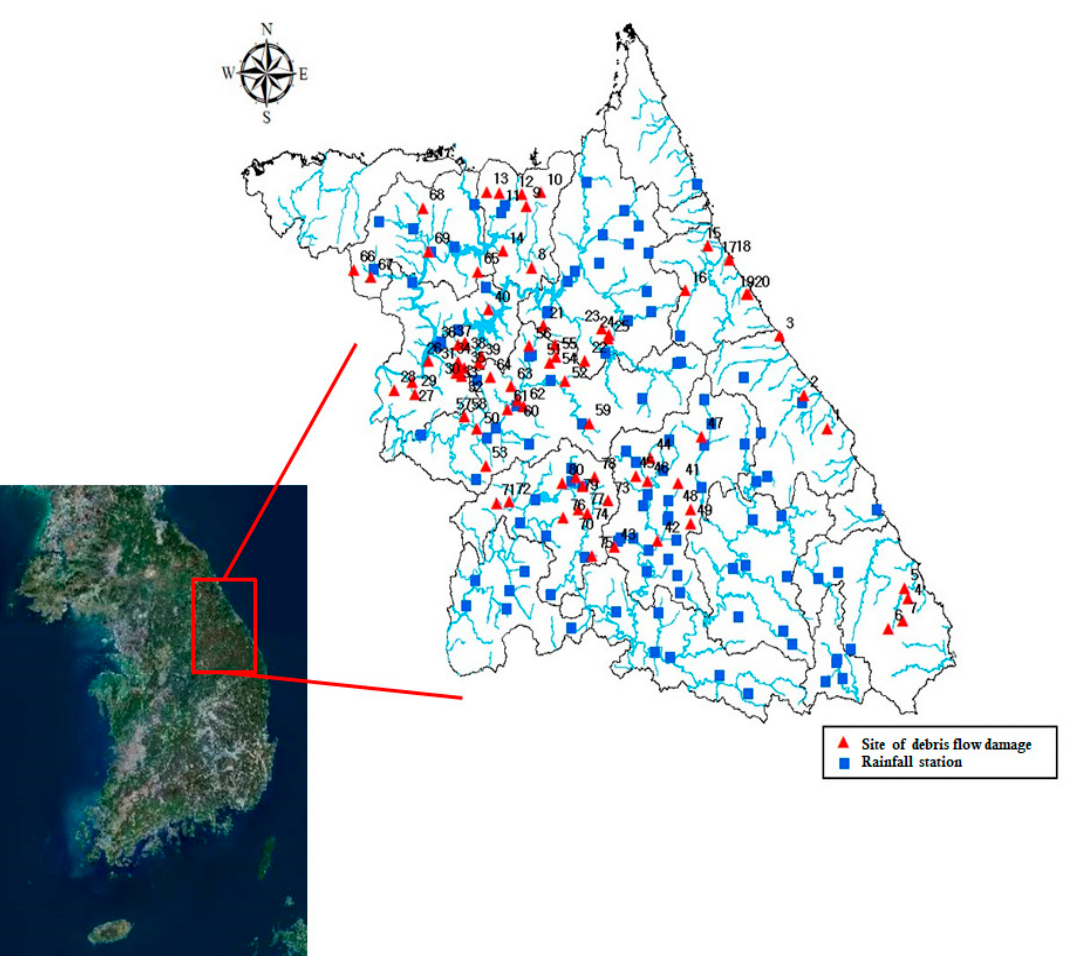
Figure 5. Positions of debris flow damage.